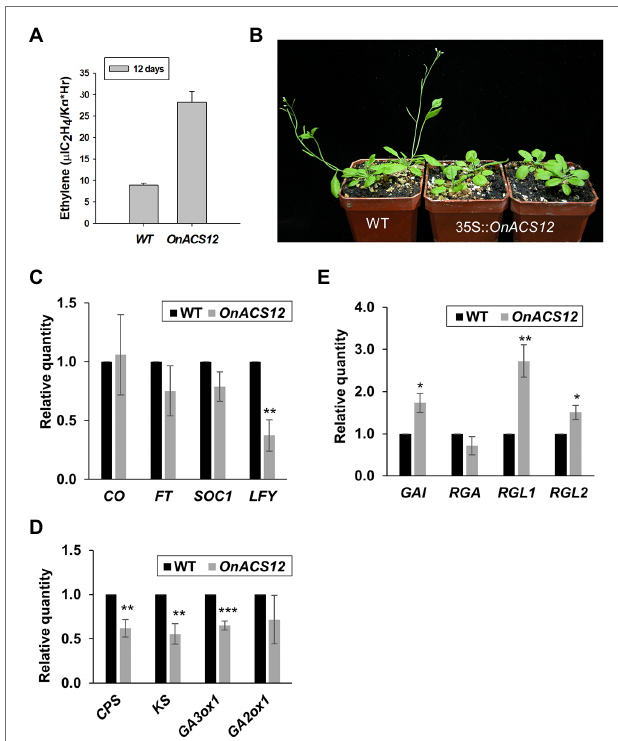
FIGURE 2 | Phenotypic analysis and detection of gene expression in Arabidopsis ectopically expressing OnACS12 . (A) Detection of ethylene production in 12-day-old wild-type (WT) and 35S:: OnACS12 seedlings. (B) Four 38-day-old 35S:: OnACS12 plants (middle and right) flowered at 43 days, much later than wild-type plants (left) when grown under LD conditions. (C–E) Detection of the expression of flowering time genes, GA biosynthesis genes and DELLAs via real-time quantitative PCR. Total RNA isolated from 35S:: OnACS12 transgenic Arabidopsis and WT Columbia plants was used as a template to detect the expression of the flowering time genes CONSTANS ( CO ), FLOWERING LOCUS T ( FT ), SUPPRESSOR OF OVEREXPRESSION OF CONSTANS ( SOC1 ), and LFY (C) , the GA biosynthetic genes CPS , KS , GA3ox1 , and GA2ox1 (D) and the DELLAs GA-INSENSITIVE ( GAI ), REPRESSOR OF GA1-3 ( RGA ), RGA-LIKE1 ( RGL1 ), and RGL2 (E) . The transcript levels of these genes were determined using two to three replicates and were normalized to UBQ10 . The expression of each gene in the transgenic plants is given relative to that of the wild-type plant, which was set at 1. The error bars represent SD. The asterisks indicate a significant difference from the WT value (* p < 0.05; ** p < 0.01; and *** p < 0.001). Statistical analysis was conducting using two-tailed Student’s t